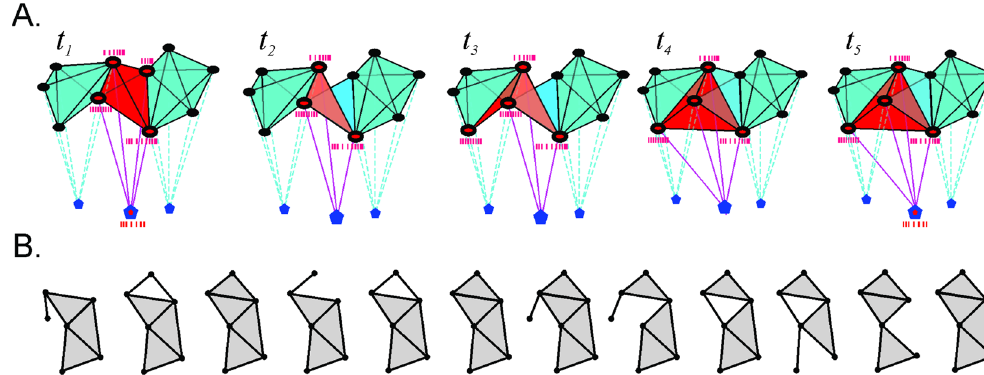
Figure 2. Place cell assemblies and flickering coactivity complexes. ( A ) Functionally interconnected groups of place cells (place cell assemblies) are schematically represented by fully interconnected cliques. The place cells (small disks) in a given assembly ς are synaptically connected to the corresponding readout neuron n ς (pentagons below). An assembly ς ignites (red clique/tetrahedron in the middle) when its place cells elicit jointly a spiking response from the readout neuron n ς (active cells have red centers). A cell assembly may be active at a certain moment of time, then deactivate, then become active again, and so forth. If a certain cell assembly ceases to ignite and another combination of place cells begins to exhibit frequent coactivity, the old cell assembly is replaced by new one. ( B ) Formation and disbanding of the cell assemblies in the hippocampal network is schematically represented by appearance and disappearance of the maximal simplexes of the “flickering” coactivity complex. The sequence of figures illustrates fluctuations in a small part of the coactivity complex shown on Fig. 1A. Since the large-scale topological information encoded by the hippocampal network should persist, one would expect that the flickering complex should retain a certain skeletal structure, capable of representing such